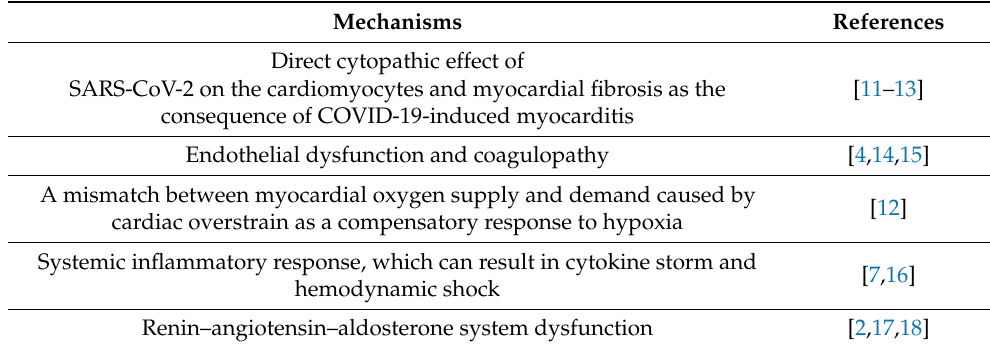
Table 1. Mechanisms of COVID-19-related cardiovascular